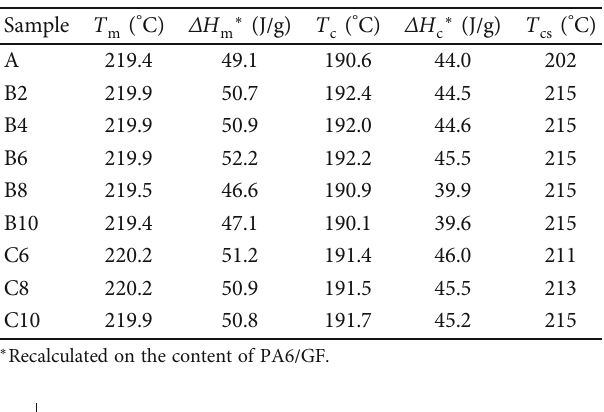
Table 2: Peak melting and crystallization temperature ( T melting and crystallization enthalpy ( Δ H m , Δ H c ), and the starting temperature of crystallization ( T cs ).